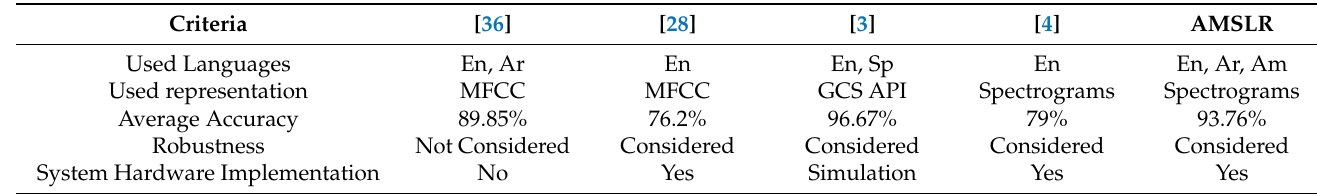
Table 3. Comparison with similar